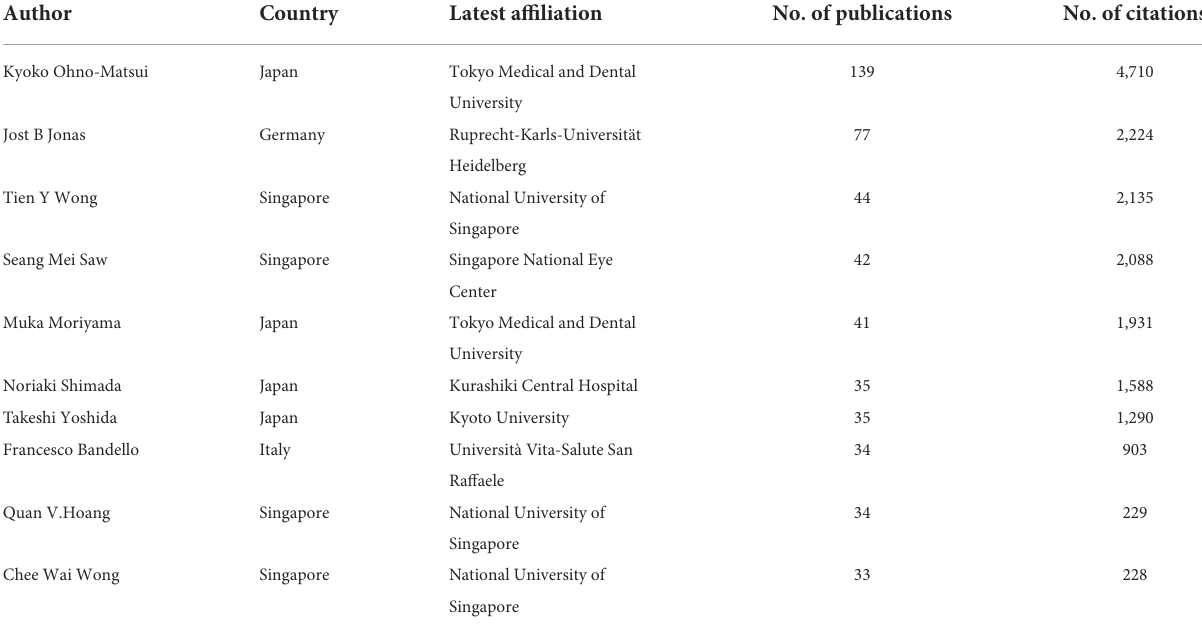
TABLE 3 Top 10 authors who published most in the field of pathologic